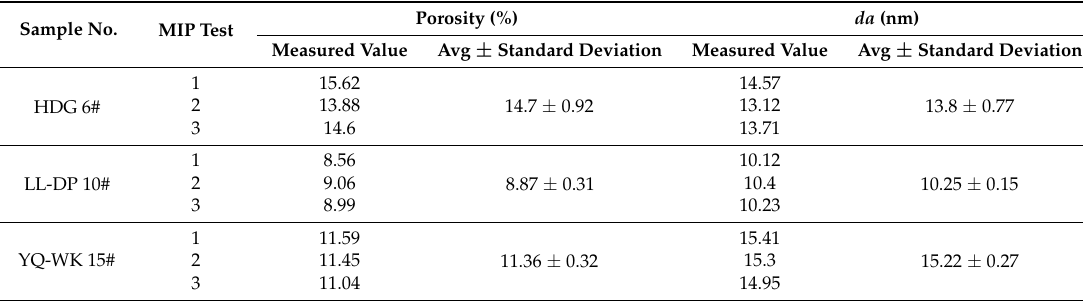
Table 3. Results of repeatability